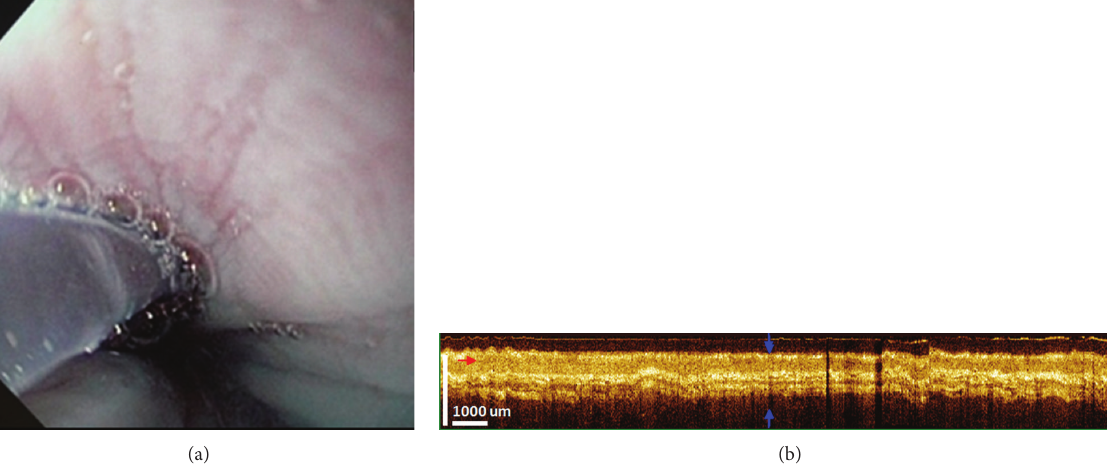
Figure1:OCTimagingofnormalesophagus.(a)Conventionalendoscopyoftheesophagusshowingsmoothpalemucosa.(b)Corresponding OCT image showing a well-defined, layered architecture. The epithelium, lamina propria, muscularis mucosa, submucosa, and muscularis propria are seen as distinct layers with alternating hypo- and hyperintensity.